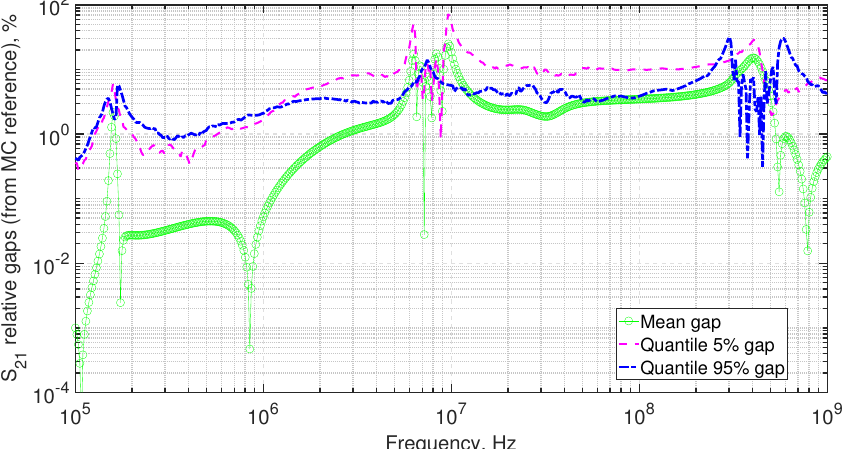
Figure 15. Relative gap between MC reference (100,000 data) and ROC simulations (1,000 realizations) from filtering performance statistics: 5%/95% confidence intervals and mean trend from Test case #1/Channel